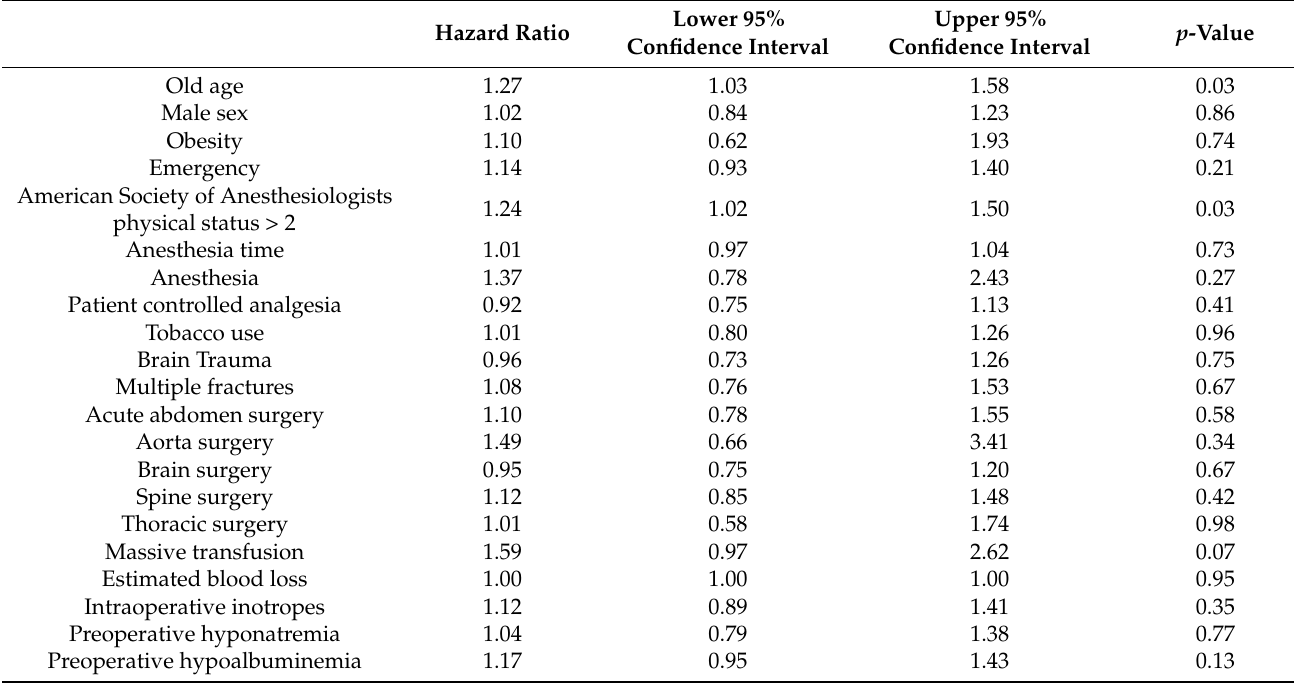
Table A2. Adjusted hazard ratios of all variables for postoperative pulmonary edema with hypoxemia. Lower 95% Hazard Ratio Confidence